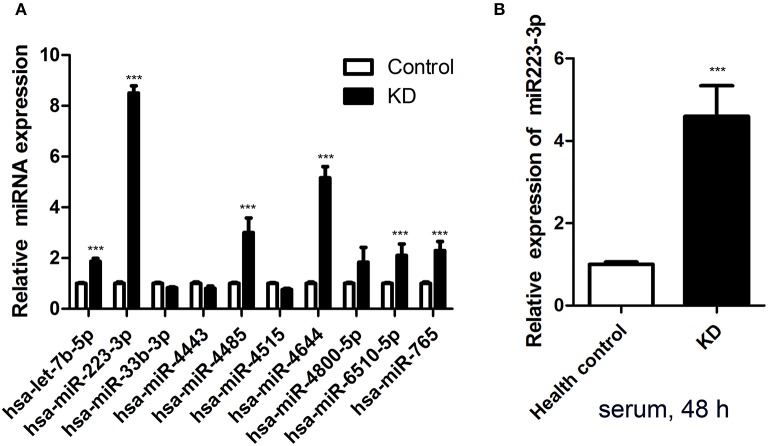
Serum miR-223-3p was increased in patients with KD. (A) The result of Affymetrix microRNA microarrays for the expression of 10 miRNAs in Kawasaki disease acute stage plasma. (B) Expression of miR-223-3p was measured in HCAECs by RT-qPCR at 48 h following culture with 2 ml serum from KD patients and healthy controls (n = 3). Data are presented as mean ± standard error of mean, ***P < 0.001.